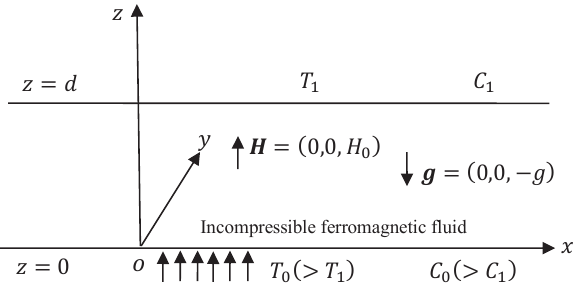
Figure 1: Geometrical configuration of the